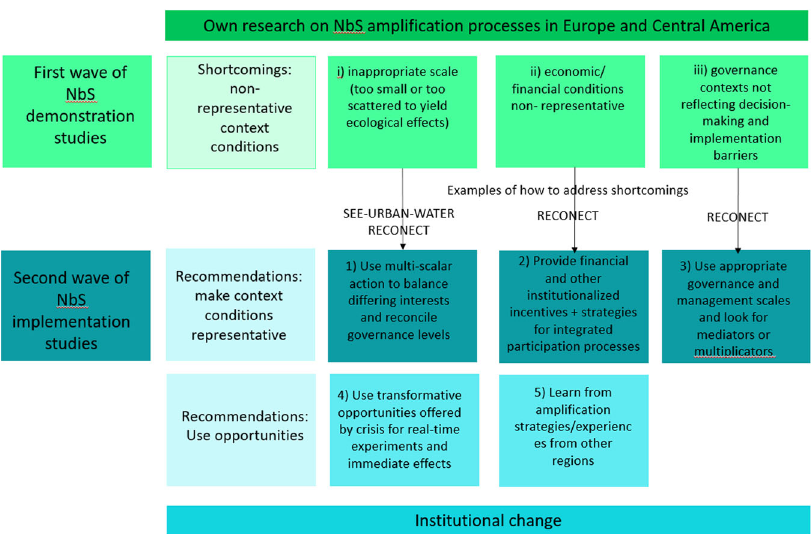
Fig. 1 From shortcomings of NbS demonstrator case studies to recommendations for institutional change. Green tiles refer to the content derived from fi rst wave NbS demonstration studies, blue tiles refer to the content derived from second wave implementation studies, SEE- URBAN-WATER and RECONECT are project examples referred to in this article that address the shortcomings of the fi rst wave of NbS demonstration